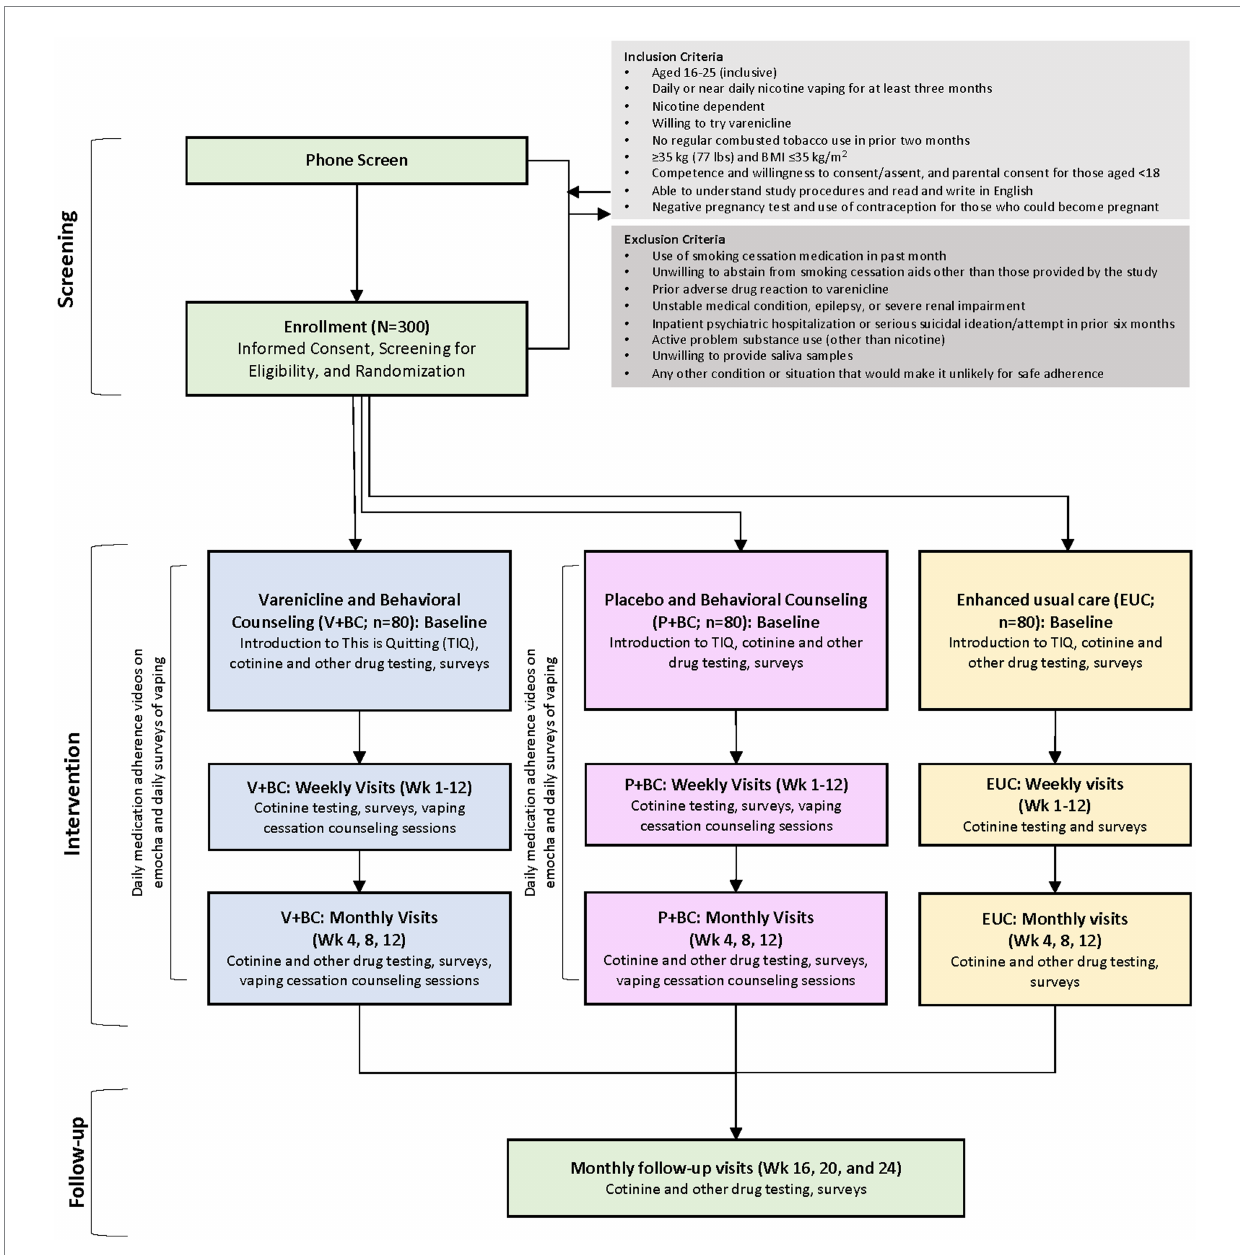
FIGURE 1 A visual description of study